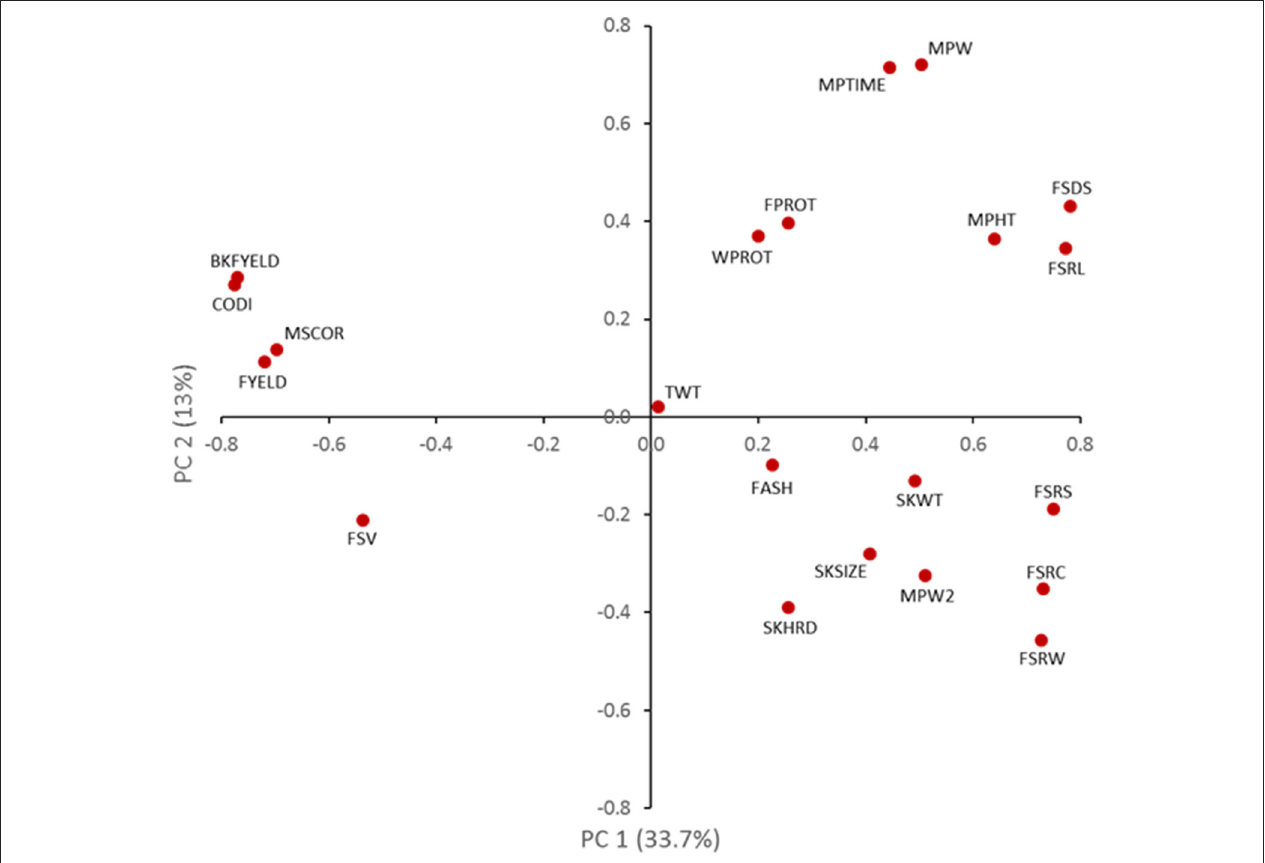
FIGURE 1 | Biplot of principal components showing the phenotypic correlation of end-use quality traits in a soft white winter wheat diversity panel. SKHRD, kernel hardness; SKSIZE, kernel size; SKWT, kernel weight; TWT, test weight; WPROT, gain protein; BKFYELD, break flour yield; FYELD, total flour yield; MSCOR, milling score; FASH, flour ash; FPROT, flour protein; FSDS, flour SDS sedimentation; FSRC, carbonate solvent retention capacity; FSRL, lactic acid solvent retention capacity; FSRS, sucrose solvent retention capacity; FSRW, water solvent retention capacity; FSV, flour swelling volume; MPTIME, mixograph peak time; MPW, mixo graph height; MPW, mixograph width; MPW2, mixograph width 2 mins; CODI, cookie